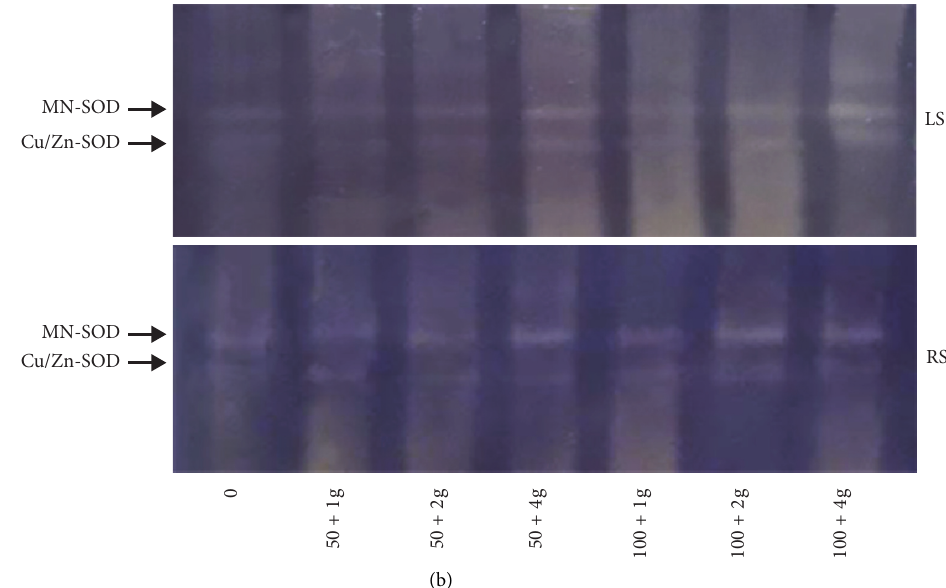
Figure 4: Effect of different sinusoidal vibrations (0, 50, and 100Hz) and accelerations (1, 2, and 4g) on the activities (a) and isoform patterns (b) of SOD enzyme in A. gilanica calli. Bars indicate mean ± SE ( n � 4) in each group. Different letters indicate significant differences at P < 0 . 05